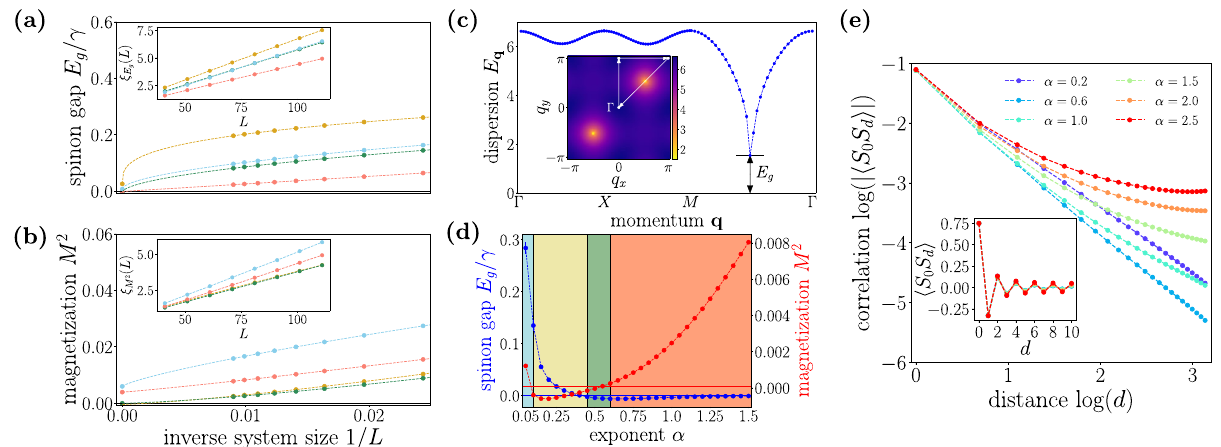
Fig. 2 Numerical characterization of the ground state. a , b Dependence of the spinon gap (upper panel) and square magnetization (lower panel) on the inverse linear system size. The curves refer to values of α and γ / J denoted in Fig. 1c by star symbols, according to the corresponding background colours. ð L Þ as functions of the linear system size L . c Spinon dispersion for The maximum linear size considered is L = 110. Insets: values of the functions ξ E g ; M 2 γ = 7 J and α = 0.3 (SL-I phase), for given cuts in the fi rst Brillouin zone. Inset: spinon dispersion in the fi rst Brillouin zone. The white lines denote the cuts of the main plot. d Extrapolated gap (blue curve) and square magnetization (red curve) as functions of the exponent α . The background colours re fl ect the phases illustrated in Fig. 1c. e Spin – spin correlation functions along the lattice axis for different values of the exponent α and for γ = 7 J . Inset: spin – spin correlations at short distances.